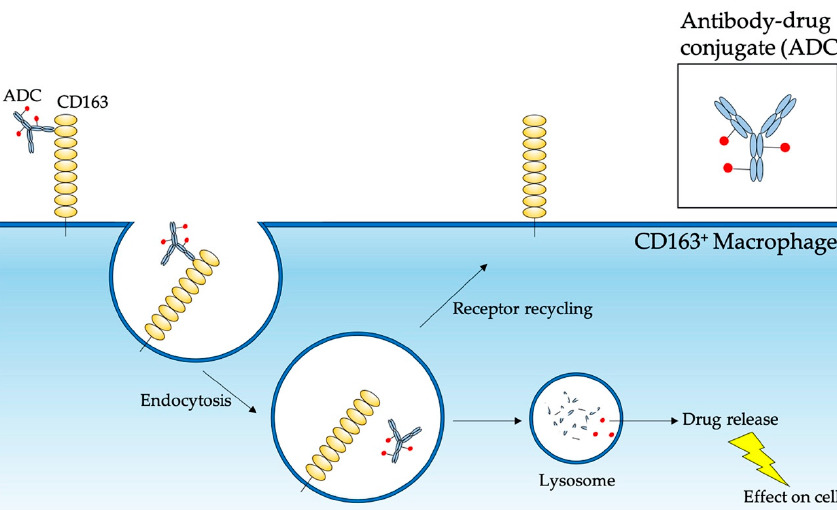
Figure 2. CD163 targeting using antibody-drug conjugates (ADC) in inflammatory and malignant diseases. CD163 is highly expressed on the surface of macrophages in many inflammatory diseases. A CD163-specific ADC is composed of a monoclonal anti-CD163 antibody which is conjugated to an anti-inflammatory or anti-tumor pharmaceutical ingredient by a chemical linker. The ADC binds to CD163 on the macrophage surface which triggers endocytosis of the conjugate. Within the exosome the ADC is released from CD163 and upon lysosome fusion the active pharmaceutical ingredient is released from the antibody to exert its function